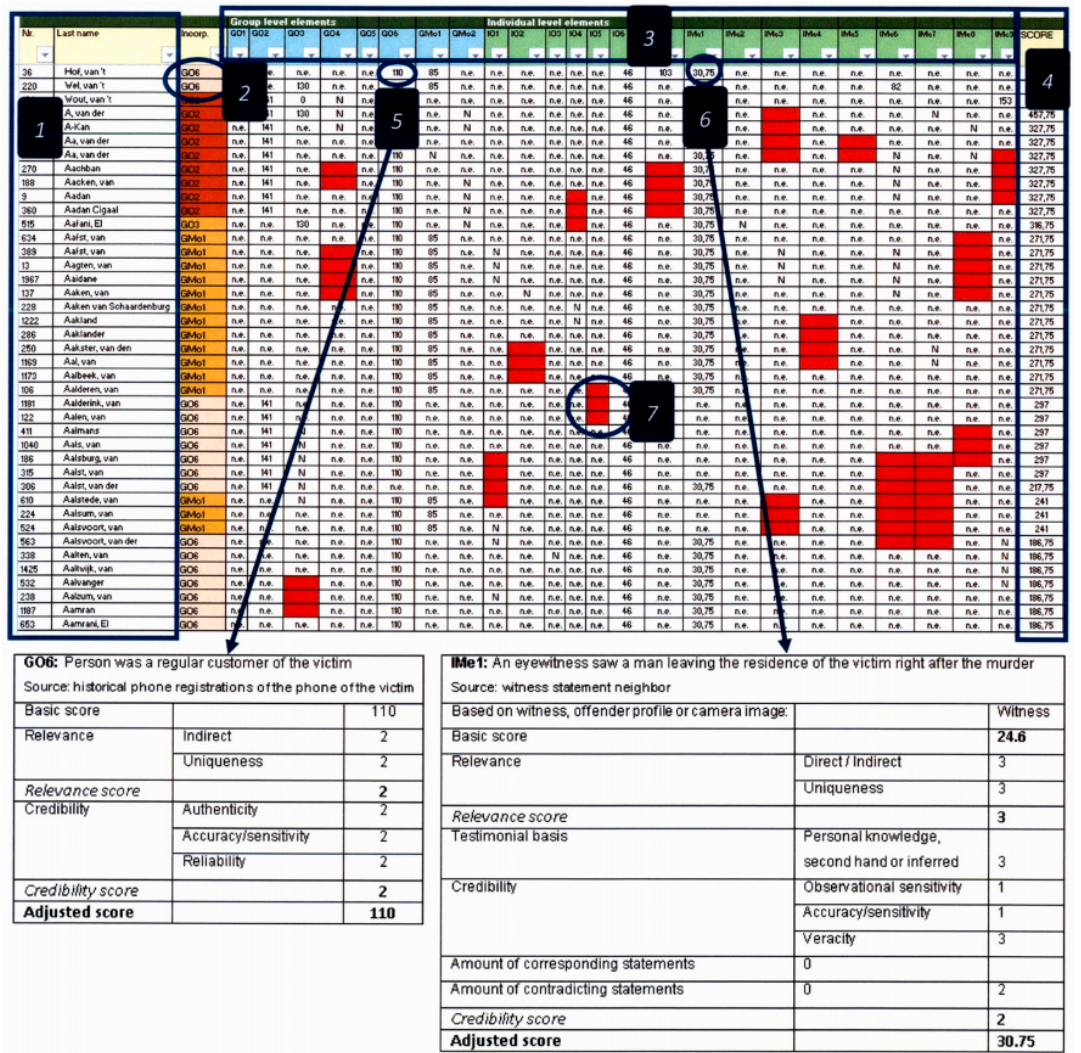
Figure 1. A walk-through of the prototype of the case-specific element library (C-SEL). The first two columns ( 1 ) are used for identifying information about the incorporated persons of interest (fictitious names are displayed for illustration purposes). The third column ( 2 ) is used to display the element that was used to incorporate the person of interest. The group and individual level elements are in columns four to twenty-seven ( 3 ). The last column shows the total score of a person of interest across all elements ( 4 ). The element that was used to incorporate a person of interest ( 5 ) is scored on the underlying factors. All other elements and underlying factors (like the person has the same gender as the description of the perpetrator (IMe1) ( 6 )) are scored. When a cell is scored ‘Y’, the accompanying score form of the underlying factors appears. After completion, the adjusted score is calculated and displayed. Cells that still need to be scored are red ( 7 ). When, after investigation, a cell could not be scored as ‘Y’ or ‘N’, it receives the score not established (n.e.) and 20% of the initial score. The screenshots are taken from the crime-related homicide case that will be outlined in the next section.